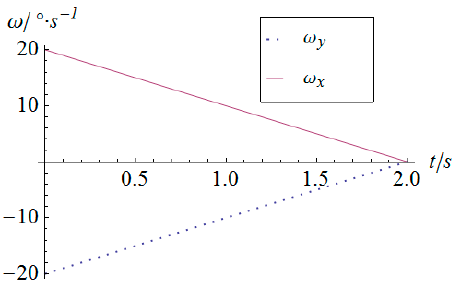
Figure 6. Angular velocity vs. time of the mobile platform.